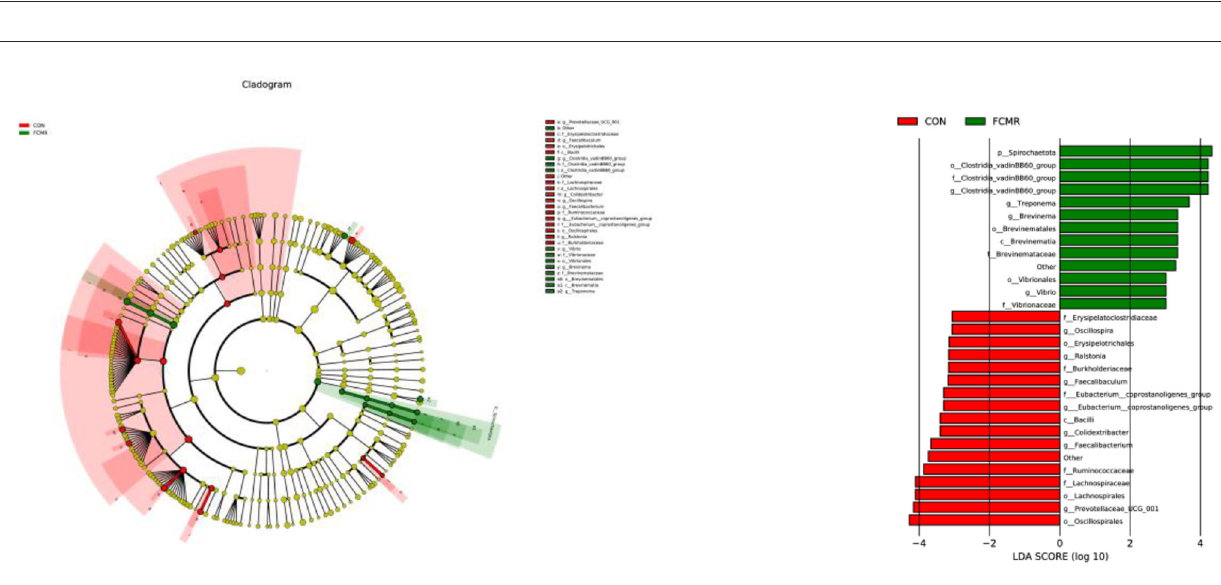
prevent the passage of pro-inflammatory molecules, but also tight junction proteins are the main barrier to the paracellular pathway, preventing the passage of large molecules through the intestinal epithelium at the paracellular level while allowing the diffusion